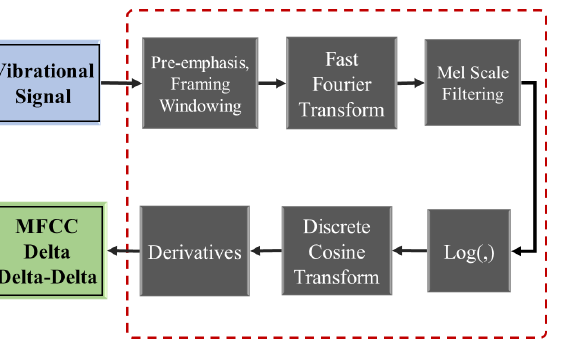
Figure 1. Mel frequency cepstral coefficient (MFCC), Delta and Delta-Delta feature extraction